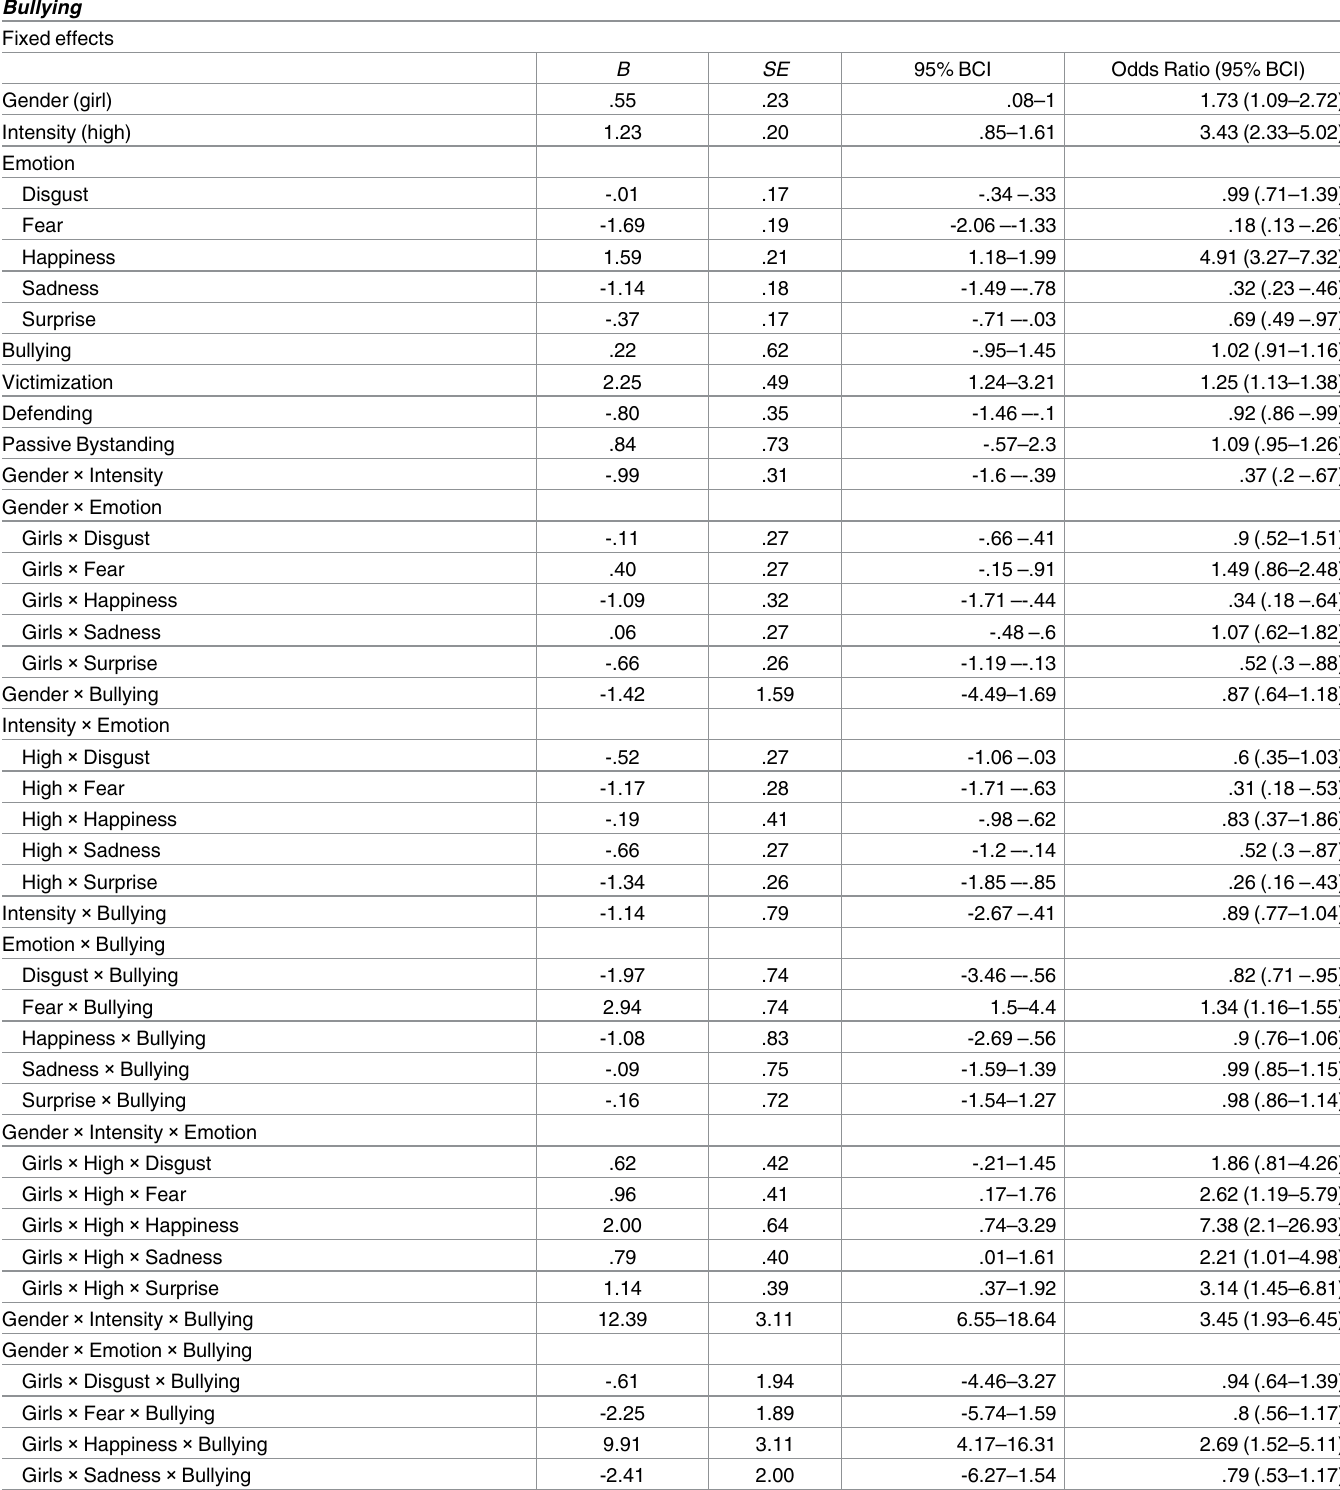
Table 7. Estimated parameters of the Bayesianlogistic mixed-effects models including four-way interactions (gender × intensity × emotion × behavior) with accuracyin emotion recognition as dependent